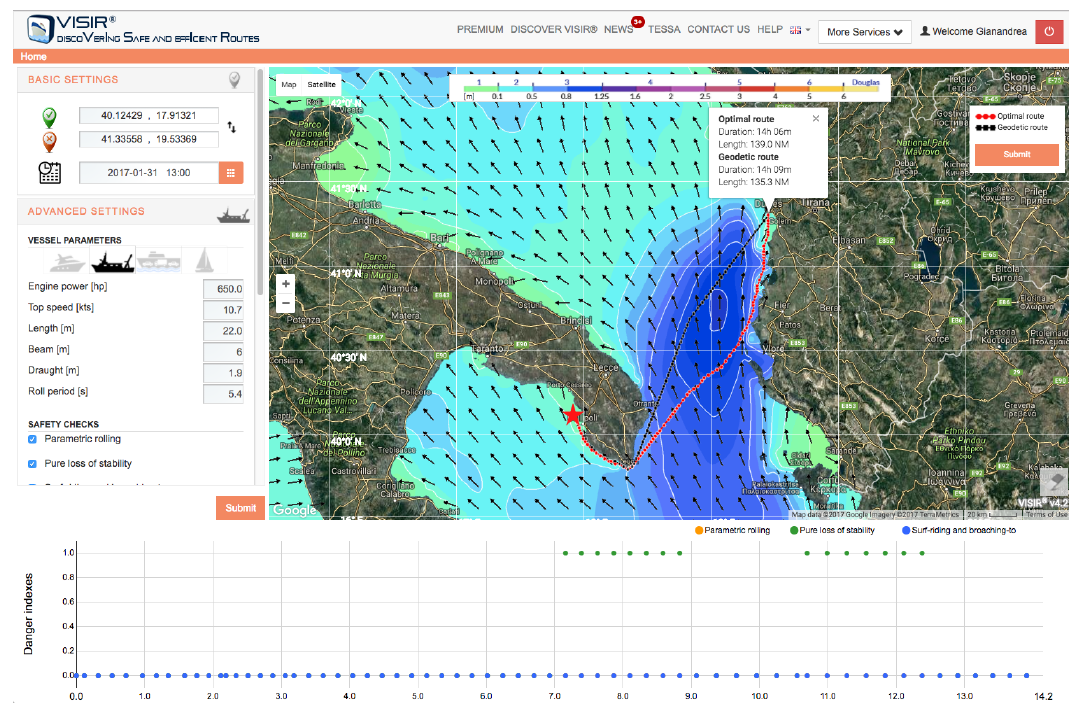
Figure 8. A motorboat route computed by VISIR. The linechart below the map shows the safety constraints that are violated by the geodetic route (black dots on the map) but not by the optimal route (red dots).